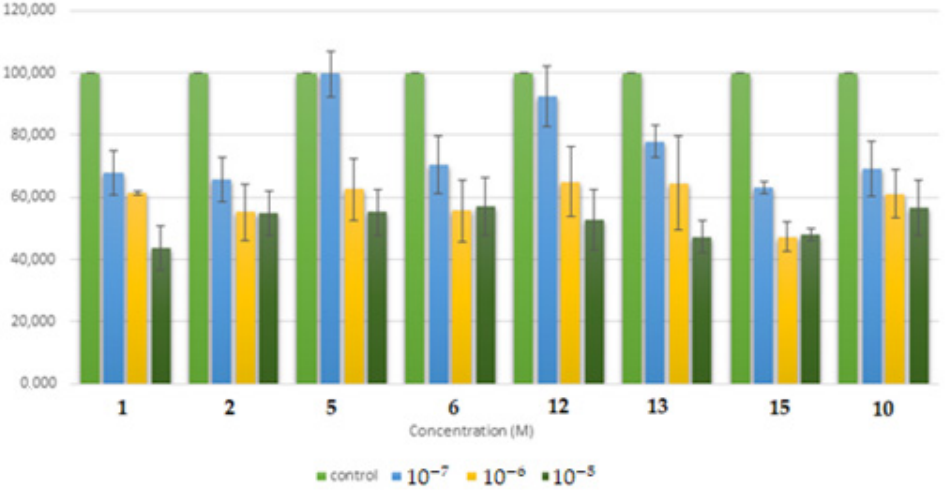
Figure 12. Cell growth kinetics of HSC-3 cells exposed for 48 h at various concentrations in culture to compounds 1 , 2 , 5 , 6 , 12 , 13 , 15 , and 10 .